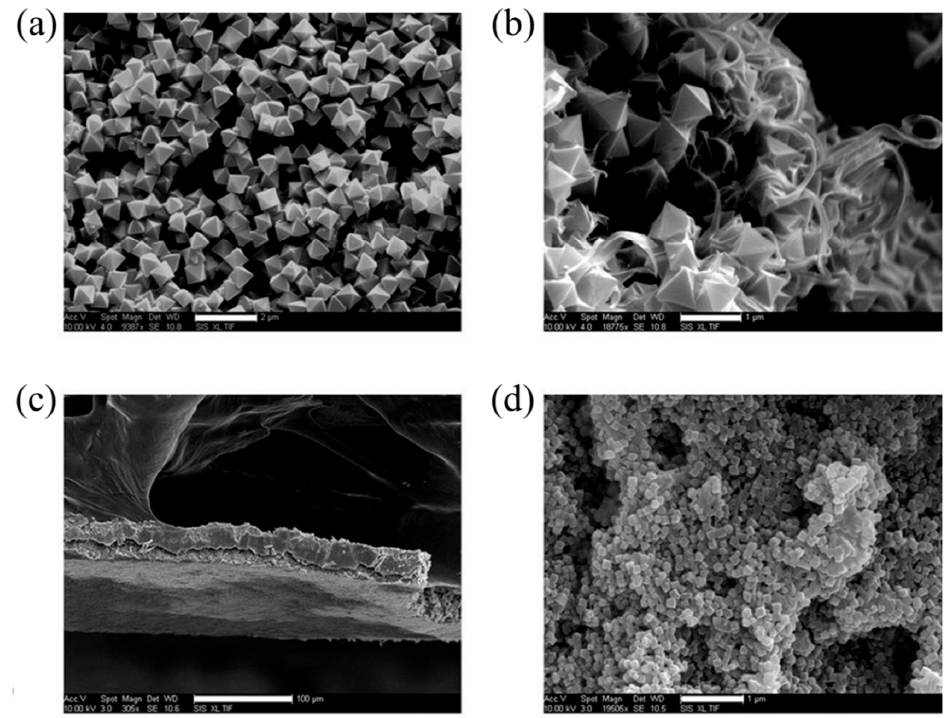
Figure 10. SEM images of ( a , b ) a top view and ( c , d ) a cross section of UiO-66 MMM. Scale bars: ( a ): 2 µ m; ( b , d ): 1 µ m; ( c ): 100 µ m. Reprinted with permission from Reference [87]. Copyright 2015